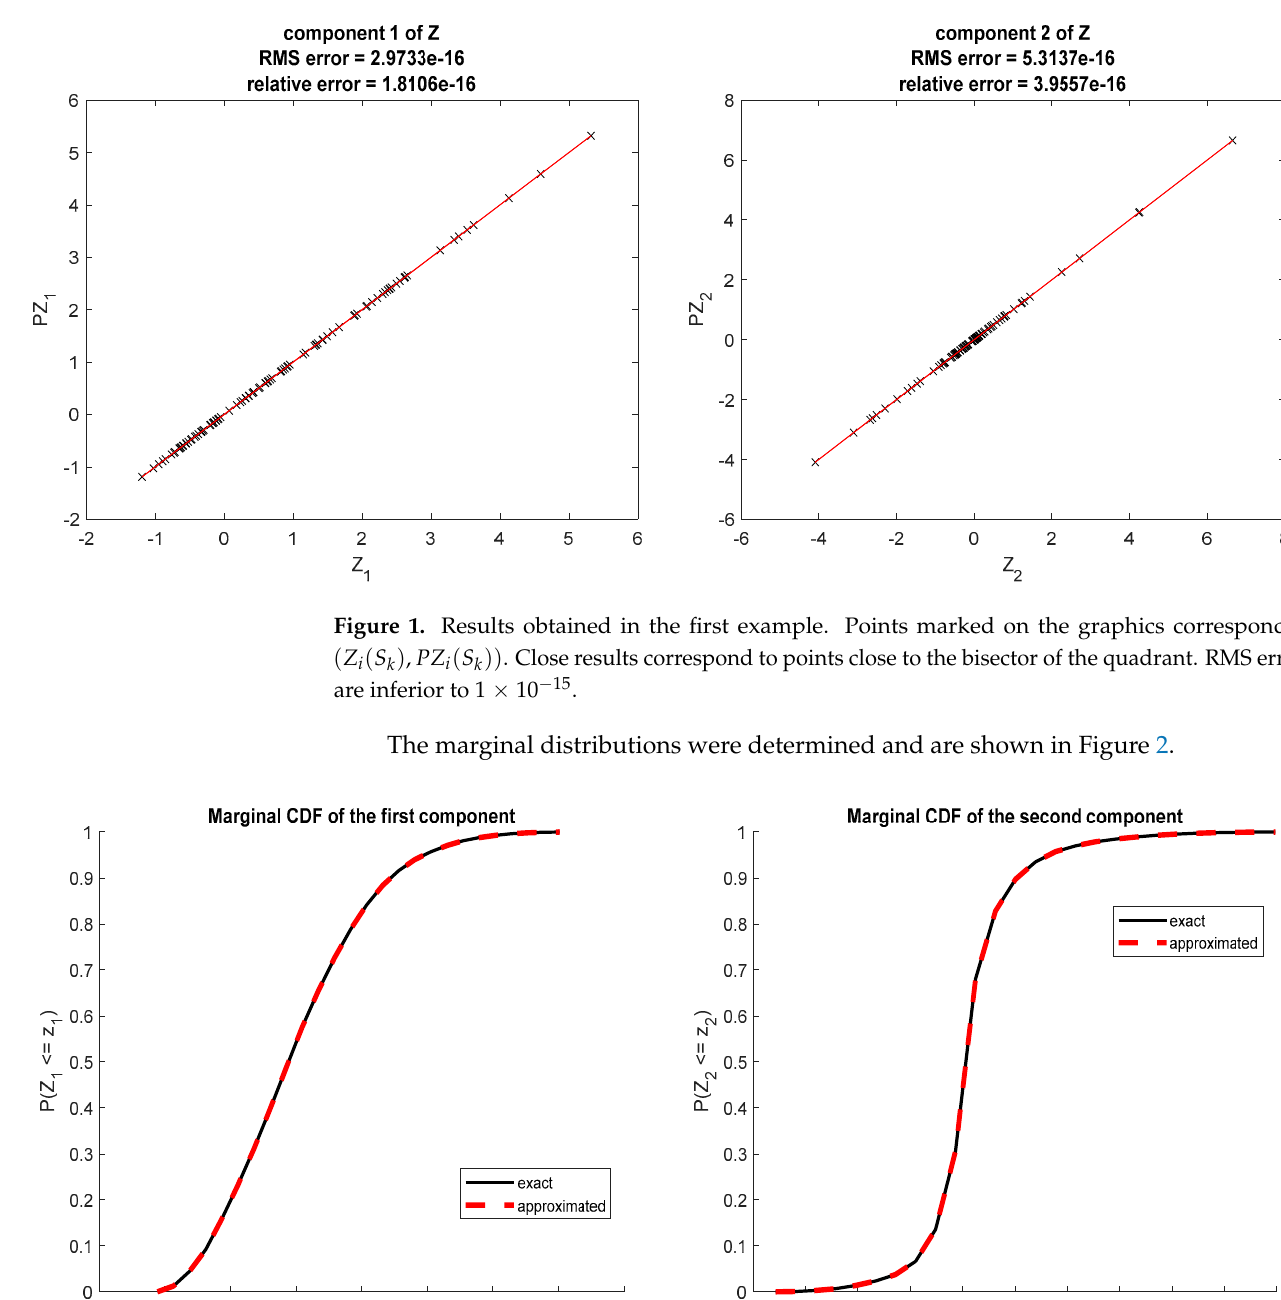
Figure 1. Results obtained in the first example. Points marked on the graphics correspond to (cid:3435)𝑍 (cid:3036) (𝑆 (cid:3038) ), 𝑃𝑍 (cid:3036) (𝑆 (cid:3038) )(cid:3439) . Close results correspond to points close to the bisector of the quadrant. RMS er- rors. are inferior to 1 × 10 − 15 .